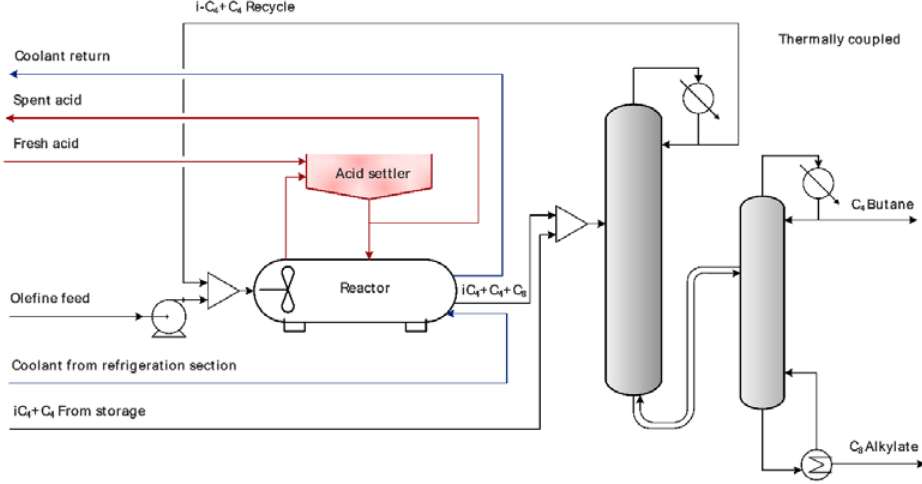
Figure 3. Alkylation process revamp option via thermal coupling of rectification columns. Adapted from [5].